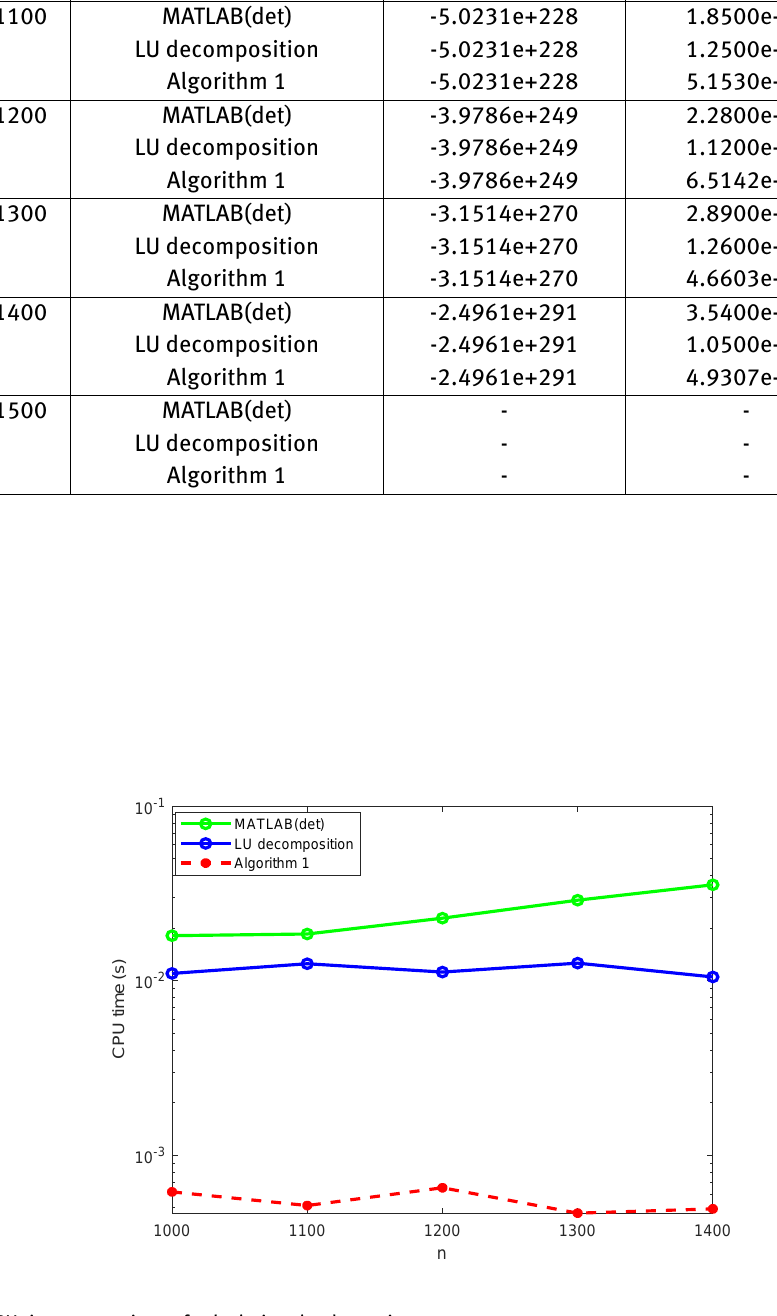
Figure 1: The CPU time comparison of calculating the